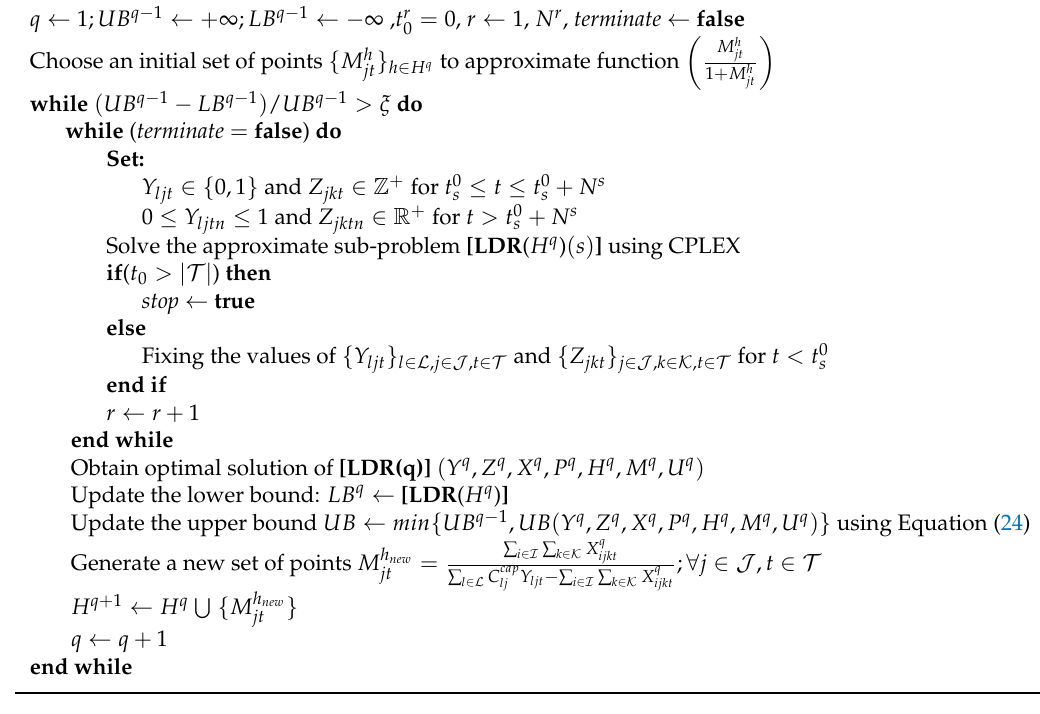
Algorithm 3 Constraint Generation with Rolling Horizon